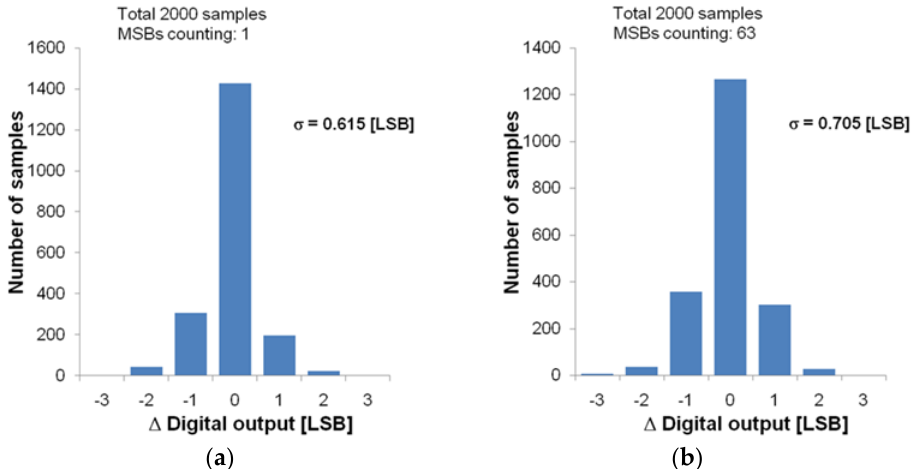
( b ) Figure 8. Measurement results of the linearity of the proposed pixel-level ADC: ( a ) differential non-linearity (DNL); ( b ) integral non-linearity (INL). SNR and DR characteristics are important figures of merit for IRFPA applications. To estimate the SNR and DR characteristics, the readout circuit noise, i.e., the ADC noise, should be measured. First, the digital output of the ADC for a zero current input was sampled 2000 times, then the readout noise for a zero current input was estimated as the standard deviation  of the sampled output. Through this process, it was confirmed that the readout noise for a zero-current input σ 0 is close to 0 LSB. However, this method alone cannot evaluate the effect of kTC noise of the DAC on the readout noise. In order to eval- uate the readout noise caused by the DAC, there must be a current input. In this case, the readout noise itself can be evaluated by eliminating the noise caused by the current input. The ADC output was sampled several times for two different current inputs, and the his- tograms were obtained as shown in Figure 9. Figure 9a,b are histograms obtained using a total of 2000 samples, where the number of MSBs counting is 1 and 63, respectively. Using the data in Figure 9, the noise of the current input system  I can be removed, and the noise equivalent to one MSB counting  M can be predicted as shown in following equation: 𝜎 𝑎2 = 𝜎 02 + 𝜎 𝐼2 + 𝜎 𝑀2